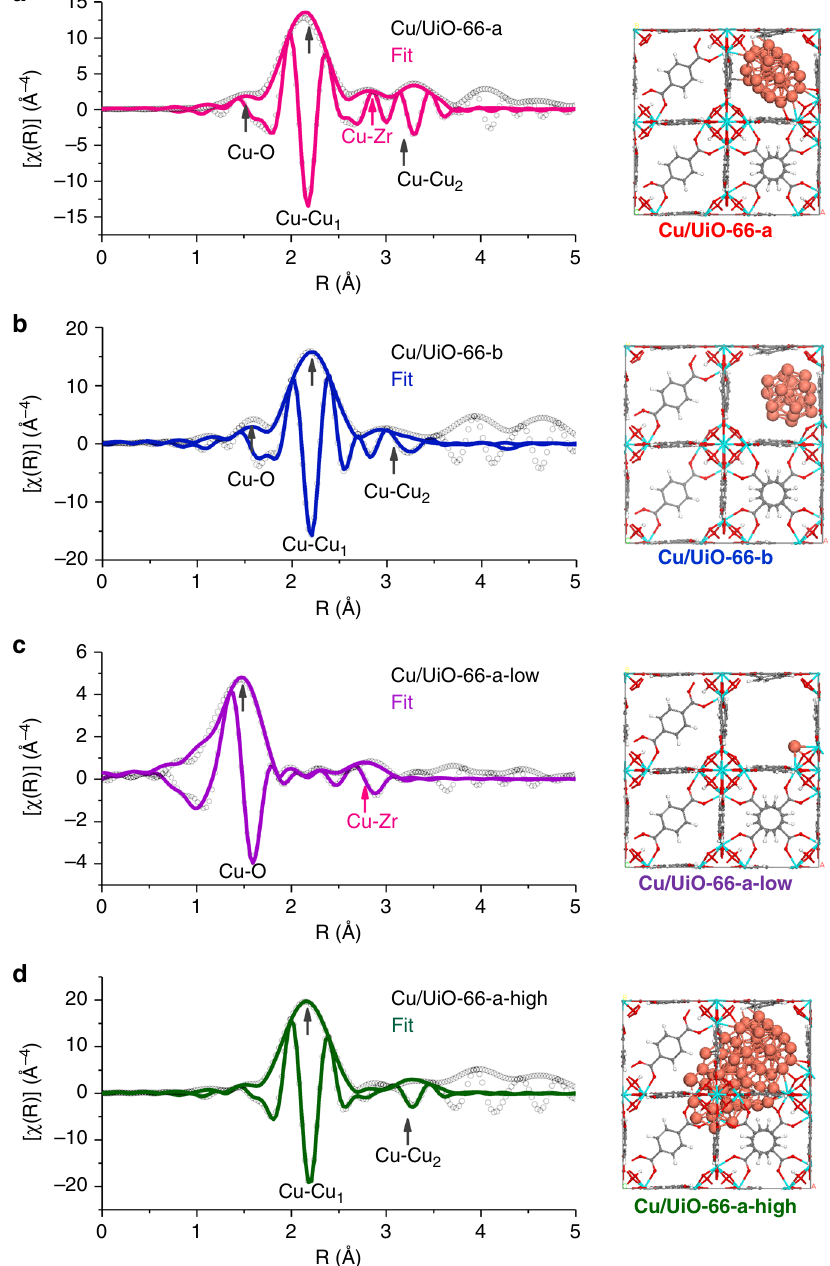
Fig. 2 Structural models of selected materials. Cu K-edge k 3 -weighted EXAFS and Fourier-transform spectra with fi tting lines of Cu/UiO-66-a, Cu/UiO- 66-b, Cu/UiO-66-a-low, and Cu/UiO-66-a-high for which the Cu – Zr path is highlighted with red arrows. The fi gures on the right side of each row are schematic structural models deduced from the EXAFS analyses. They show the interface bonding of sub-nanometer Cu clusters with Zr 6 O 8 nodes for Cu/ UiO-66-a ( a ), the non-proximity of Cu clusters with Zr 6 nodes for Cu/UiO-66-b ( b ), the bonding of isolated Cu with Zr 6 nodes for Cu/UiO-66-a-low ( c ) and the higher fraction of metallic Cu species for Cu/UiO-66-a-high ( d , where the Cu – O and Cu – Zr paths are negligible for the EXAFS fi